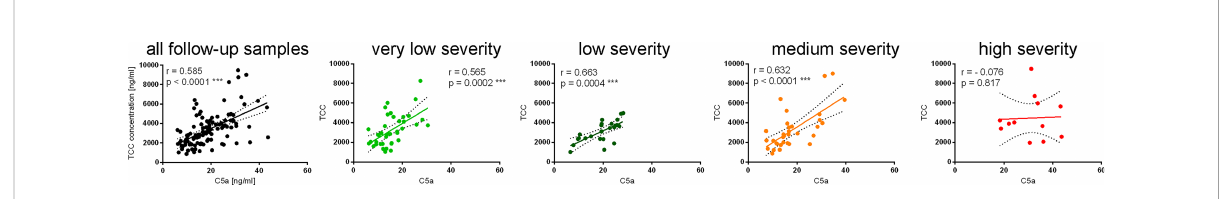
FIGURE 3 Correlations of C5a and TCC in patients ’ serum samples collected during follow-up. The results of the C5a and TCC measurements were originally published in ref. 1; herein, we present the correlation of data obtained for all follow-up samples and for each severity group separately. The 95% con fi dence band of the best- fi t line is shown. Symbols *** denotes statistical signi fi cance at p level <